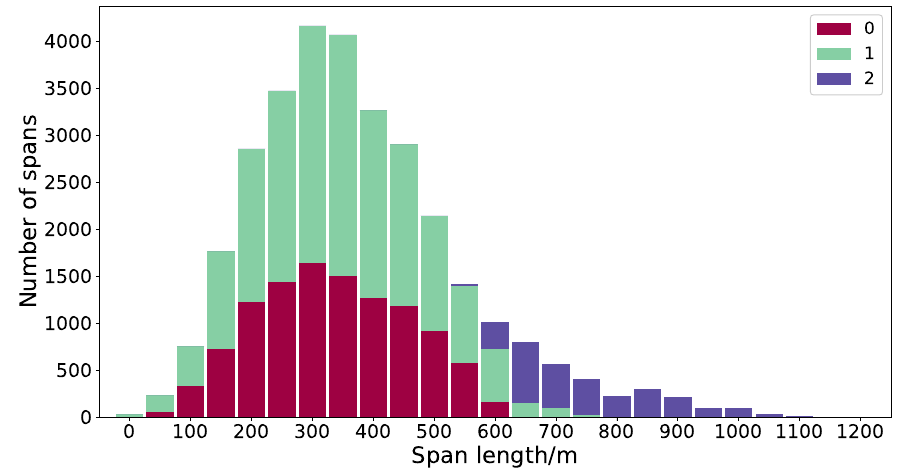
Figure 7. Span length distribution of 3